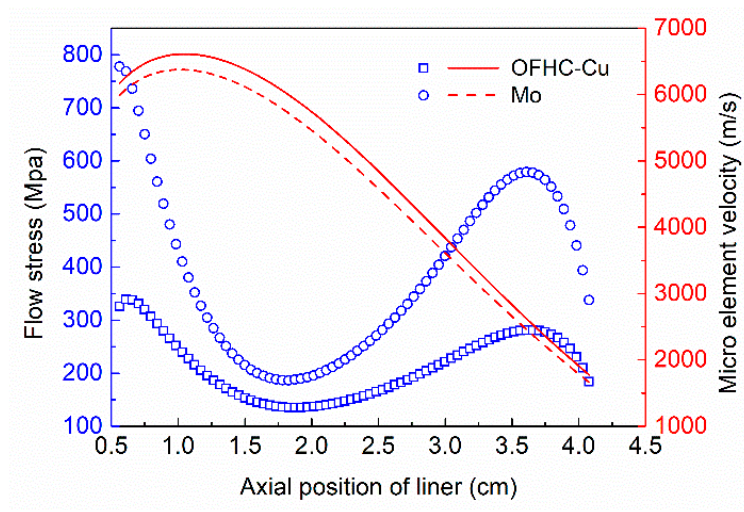
Figure 12. Flow-stress distribution of the jets.